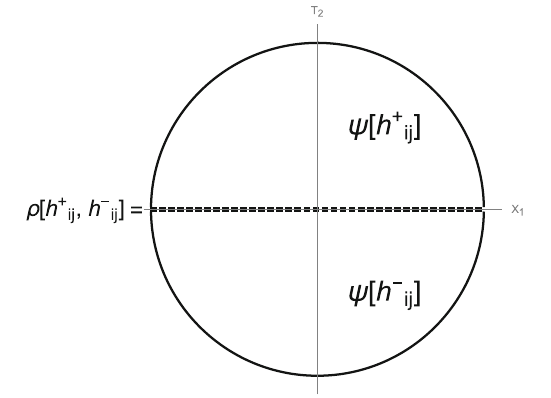
Fig. 3 The two disjoint geometries that geometrically represent the density matrix associated with the state in Fig. 2